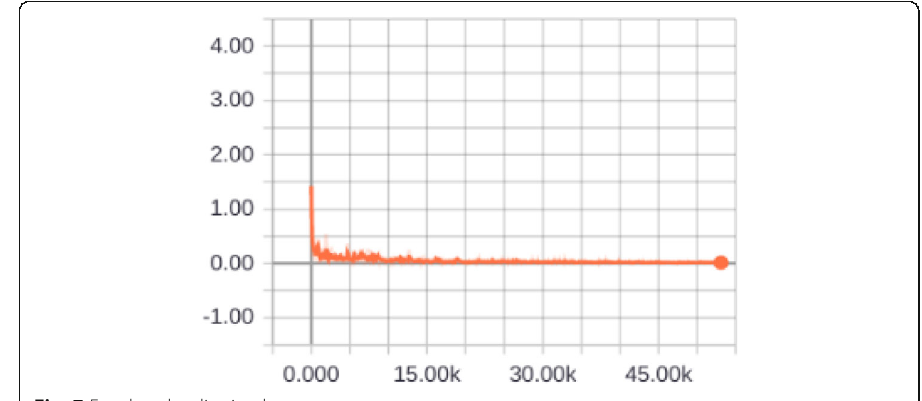
Fig. 7 Epoch vs localization loss